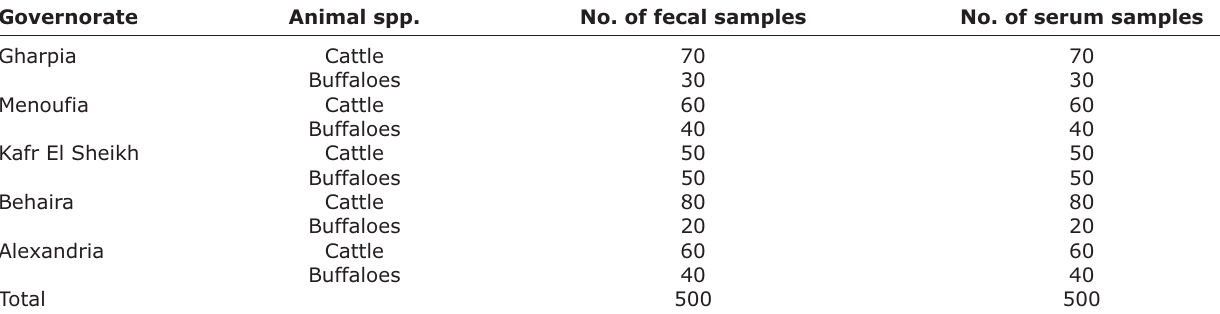
Figure-1: Overview of the study design. Fecal and blood samples were collected from 500 animals (cows and buffaloes) of 2 years old present in 5 Governorates throughout Egypt. Fecal samples were decontaminated and examined for MAP on the basis of a strategic pooling procedure. Smears were prepared from decontaminated pellet and after culture from developed colonies, and stained using a Ziehl- Neelsen (ZN) technique. The identity of developed colonies was further confirmed by PCR analysis of IS sequence. Serum samples of culture- positive and culture-negative animals were evaluated individually for humoral response.